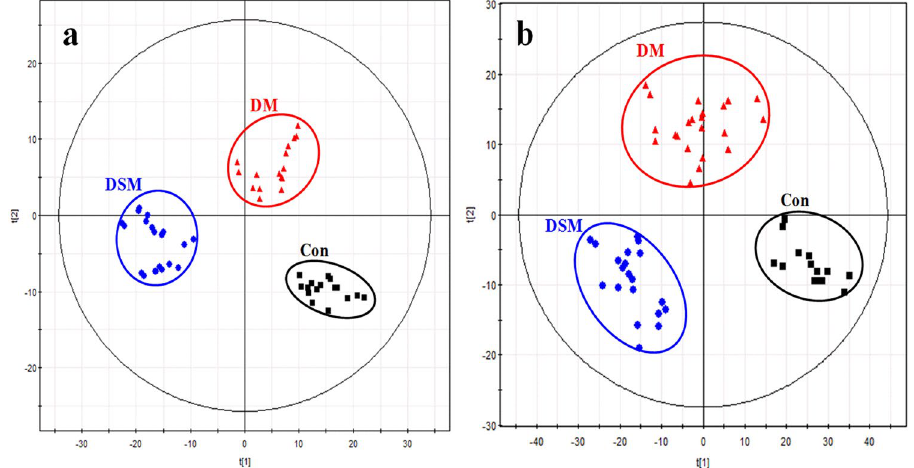
Figure 5. PLS-DA score plots of control group and model groups. ( a ) Comparison of groups in positive ion mode (R 2 X(cum) = 0.349, R 2 Y(cum) = 0.990, Q 2 Y(cum) = 0.944); ( b ) Comparison of groups in negative ion mode (R 2 X(cum) = 0.279, R 2 Y(cum) = 0.989, Q 2 Y(cum) = 0.919). Con, control group; DM, disease model group; DSM, DS model